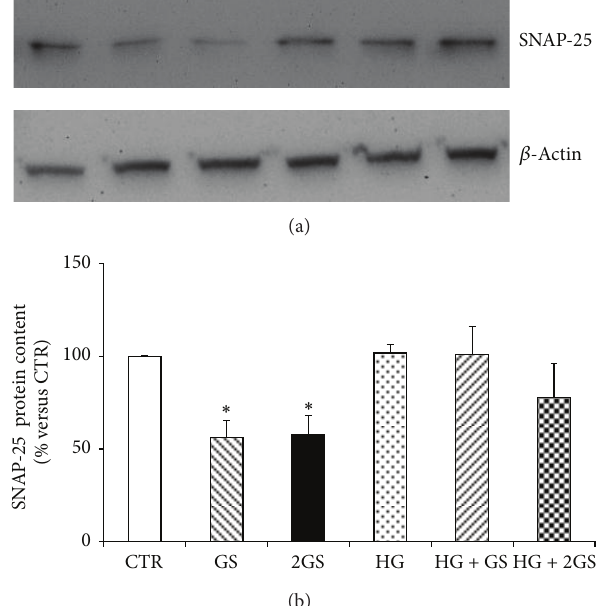
Figure 5: GS decreases SNAP-25 protein content. (a) Representative western blot analysis. (b) Quantification of densitometries of west- ern blot bands. Data were expressed as mean ± SE of fold induction relative to 𝛽 -actin ( 𝑛 = 4 ). ∗ 𝑃 < 0.05 versus CTR.